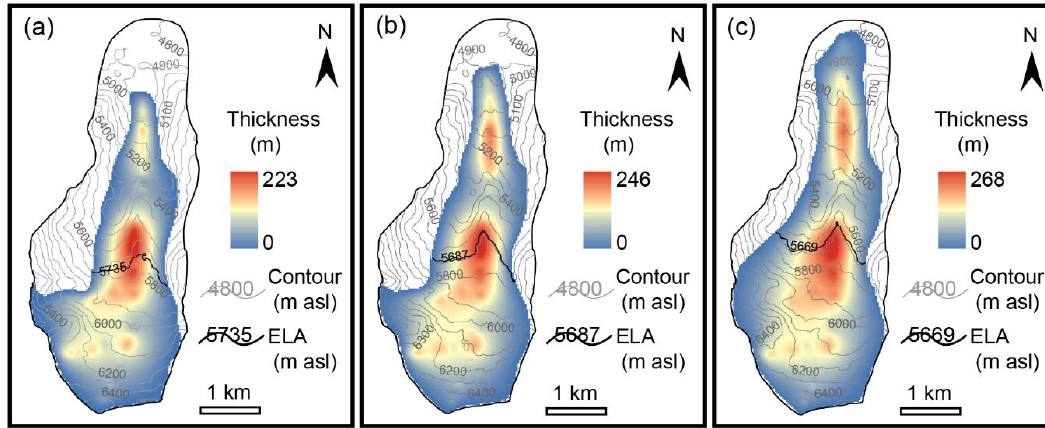
Figure 5. Reconstructed surfaces, ELAs (AABR = 1.75) and thicknesses of paleo-glaciers during Little Ice Age ( a ), Neoglacial ( b ) and early Holocene ( c ).